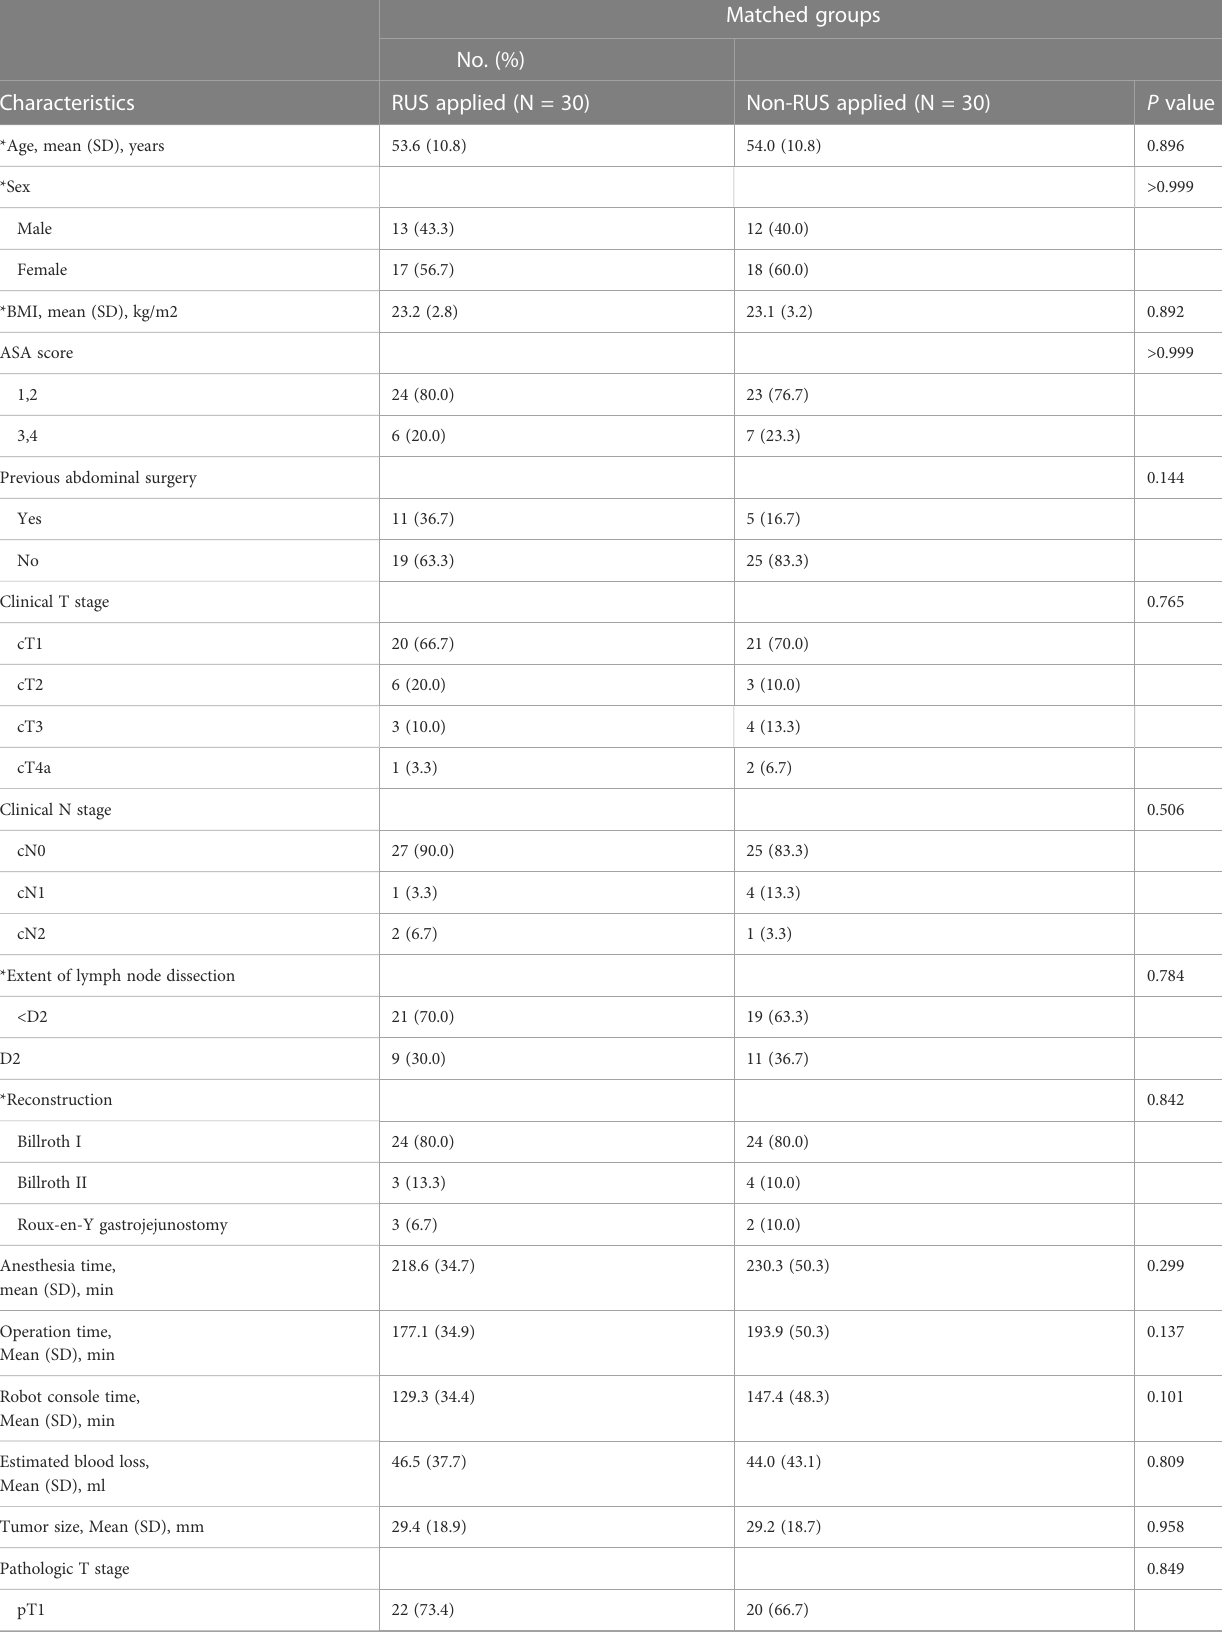
TABLE 1 Comparison between experimental (RUS ™ applied) and control group after propensity score